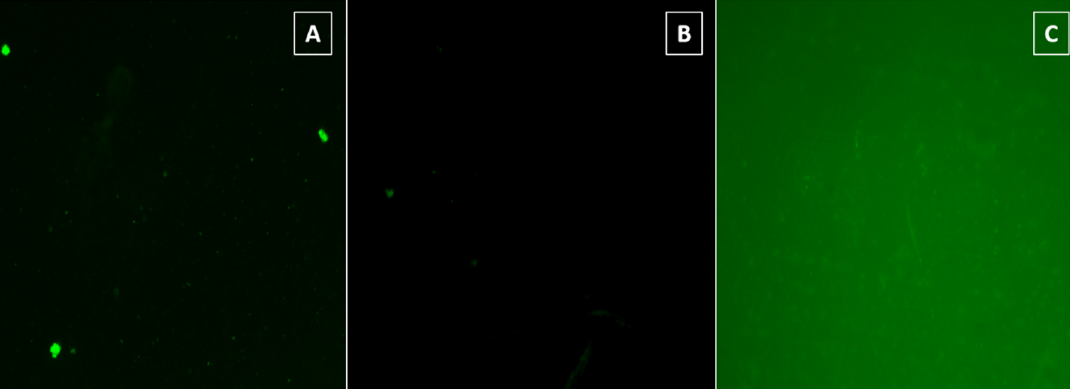
Figure 2. Representative fluorescence images of ( A ) hydrolyzed PLLA film, ( B ) conjugation of dansyl derivative 2b onto PLLA film via PB, and ( C ) conjugation of dansyl derivative 2a onto PLLA film via PA.